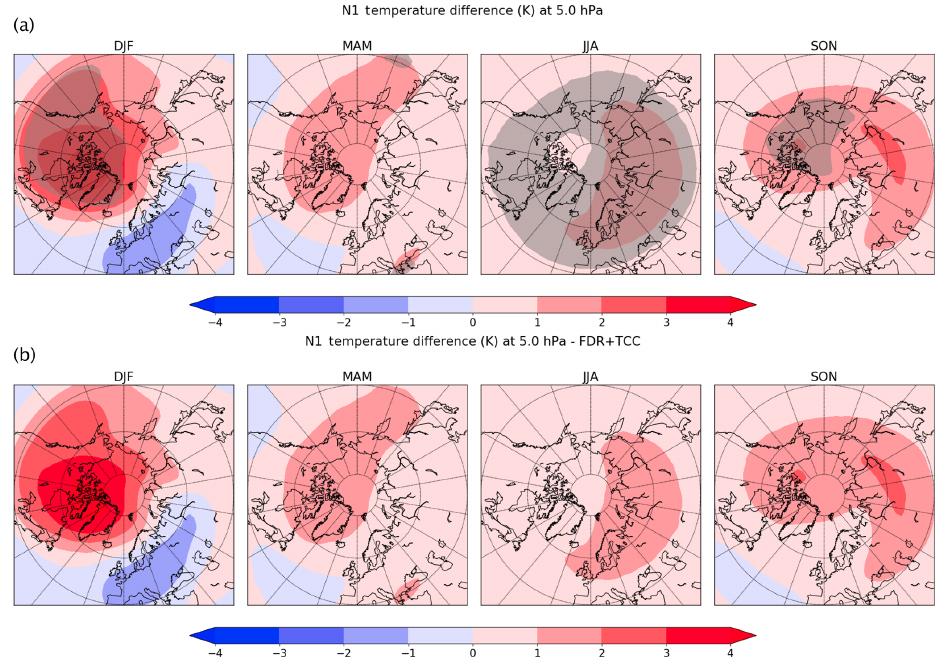
Figure 2. Northern Hemisphere seasonal differences in stratospheric temperature (high-Ap–low-Ap values) at 5hPa without (a) and with (b) temporal (TCC) and spatial (FDR) autocorrelation correction. Grey areas represent statistically significant temperature differences at the 5% confidence